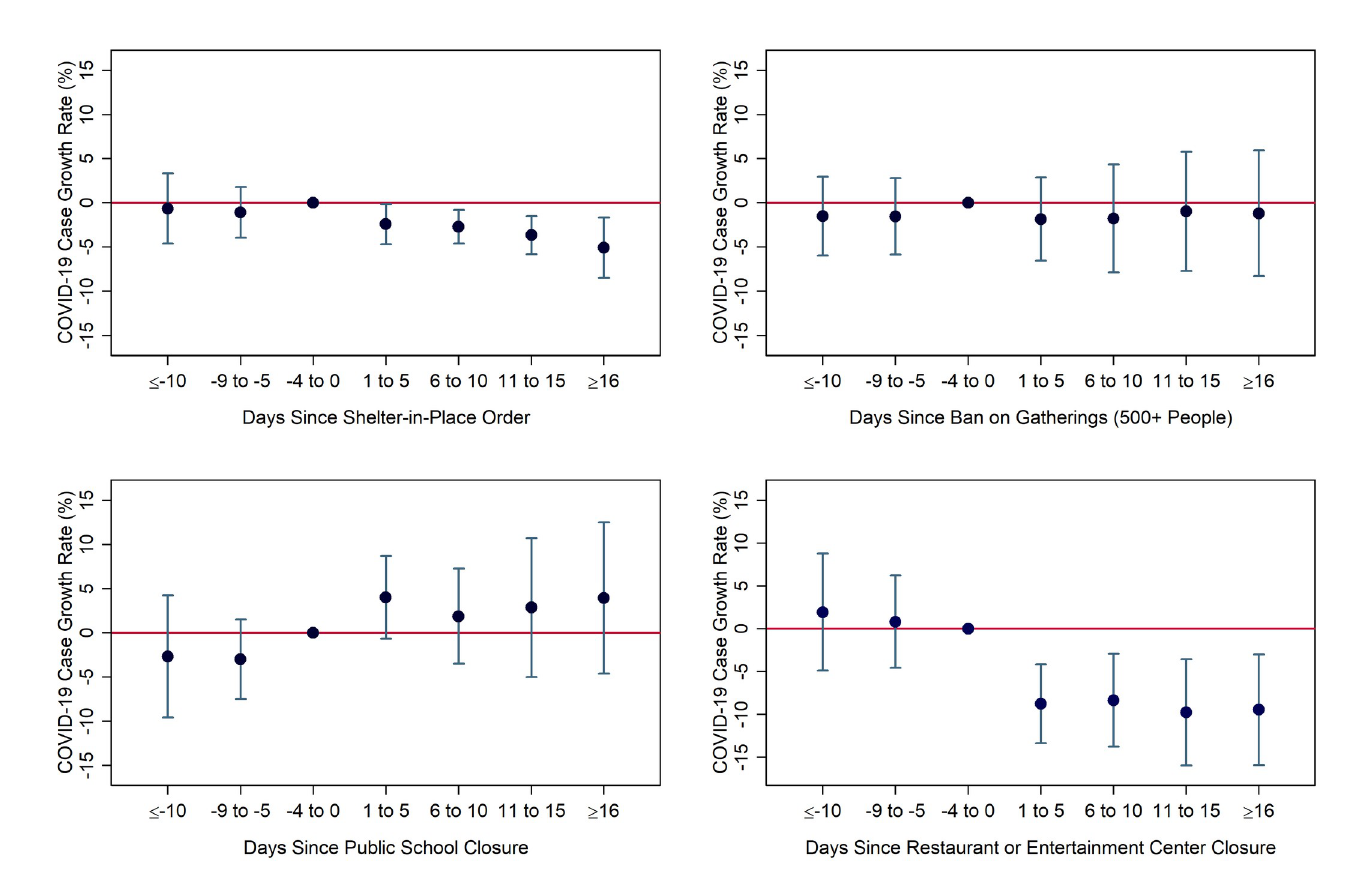
Fig 5. Predicted effects of social-distancing measures in Louisville-Jefferson County and Lexington-Fayette County. Notes: Coefficients and 95% confidence intervals were derived from authors’ event-study regression using daily county-level data from March 5-April 25 from the South and Midwest Census Regions, weighted by population. Day and county fixed effects were included. Standard errors were heteroskedasticity-robust and clustered by state. Specifications include interactions between the regulation indicators and the “white working-class” index variable. Results shown are linear combinations of uninteracted and interacted policy variables, evaluated at the average index value of -0.29 in the two